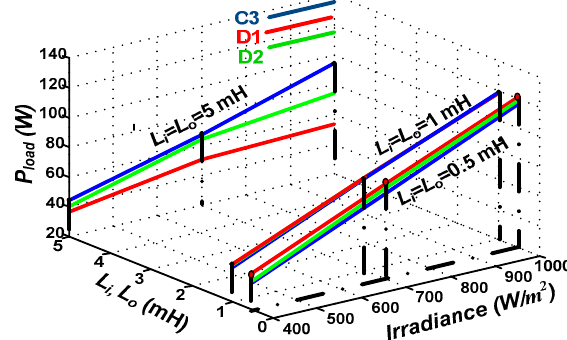
Figure 8. Converters’ load power under different cases.